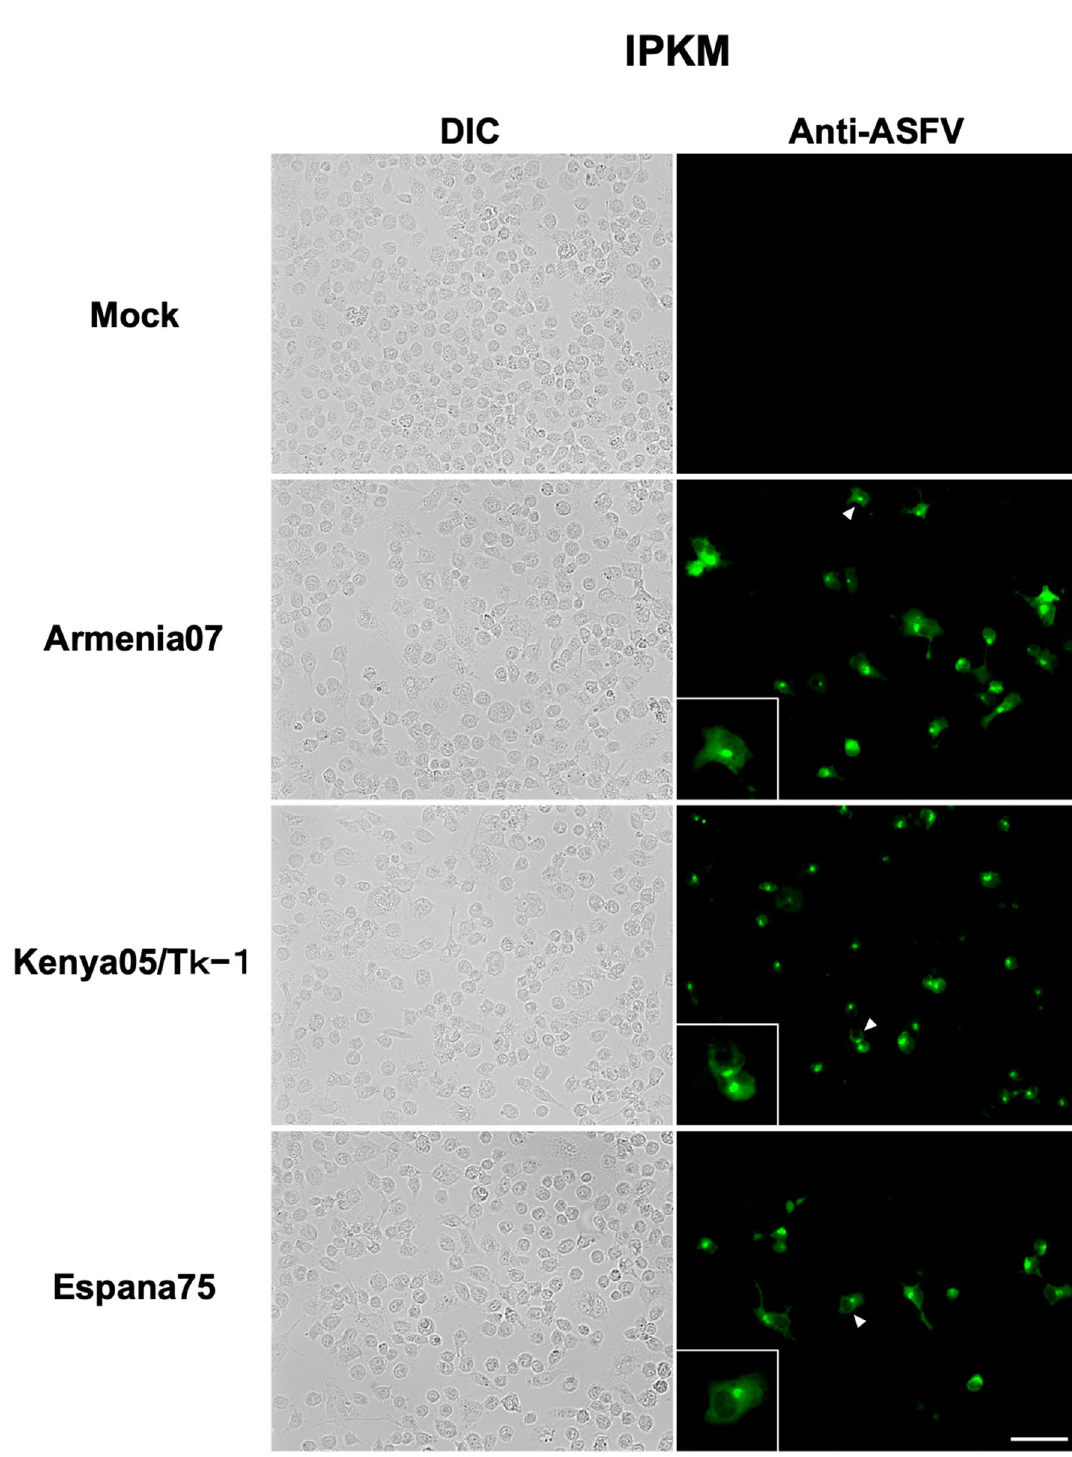
Figure 1. Immunofluorescence assay in immortalized porcine kidney macrophages (IPKM). IPKM cell cultures were mock-inoculated or inoculated with Armina07, Kenya05/Tk-1, and Espana75 isolates (MOI = 0.1), fixed at 16 h post inoculation, and incubated with FITC-conjugated anti-ASFV antibodies to detect the viral particles. The left and right columns show differential interference contrast (DIC) and fluorescence images, respectively. The images are representatives from five independent experiments. The inserts in the lower left corners of the fluorescence images are magnified images of the cells, indicated by arrowheads in their corresponding panels. Bar = 50